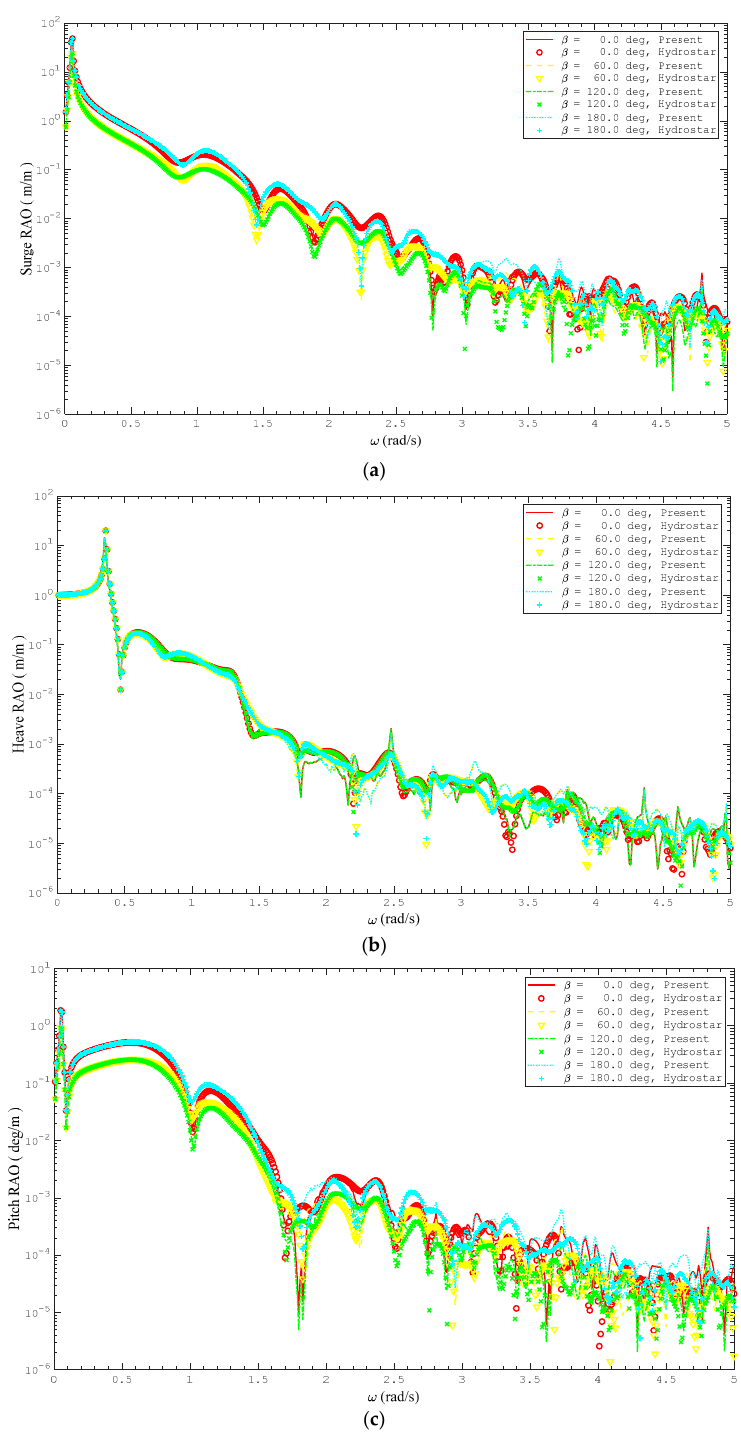
Figure 12. Motion response of the OC4 DeepCwind floating wind turbine in no-wind and parking conditions as a function of the wave angular frequency ω : ( a ) surge response; ( b ) heave response; and ( c ) pitch response. The results denoted by symbols are computed by the commercial software Hydrostar ®